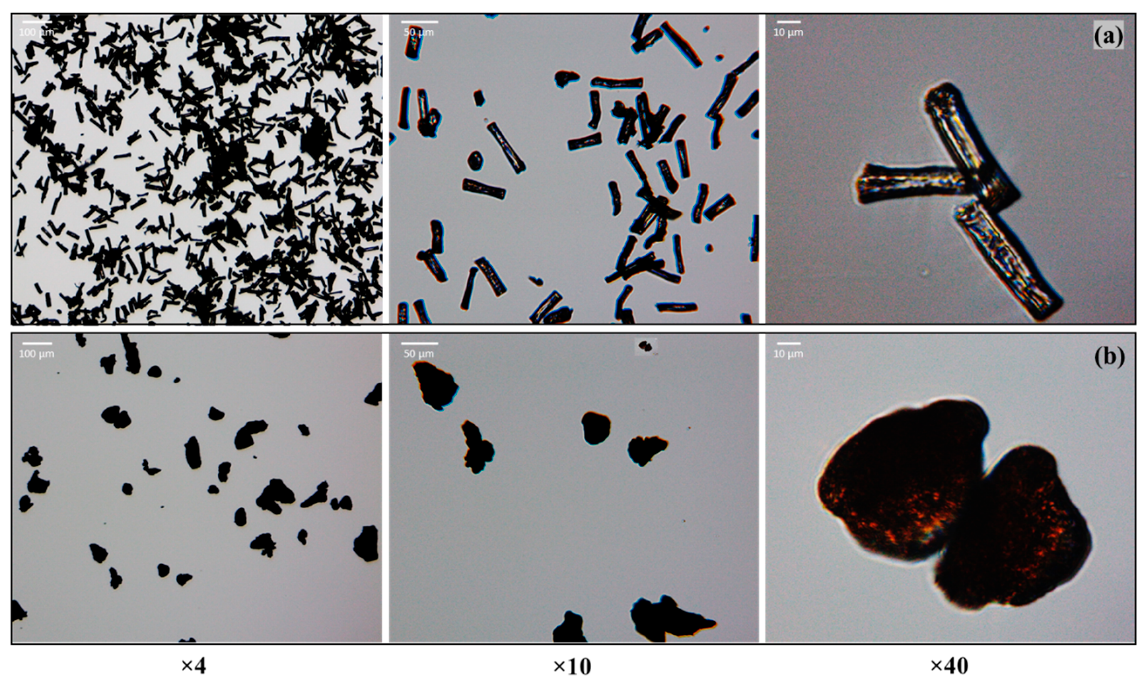
Figure 7. Stereomicroscopic images of ( a ) CMFs and ( b ) MRPs at different magnifications.